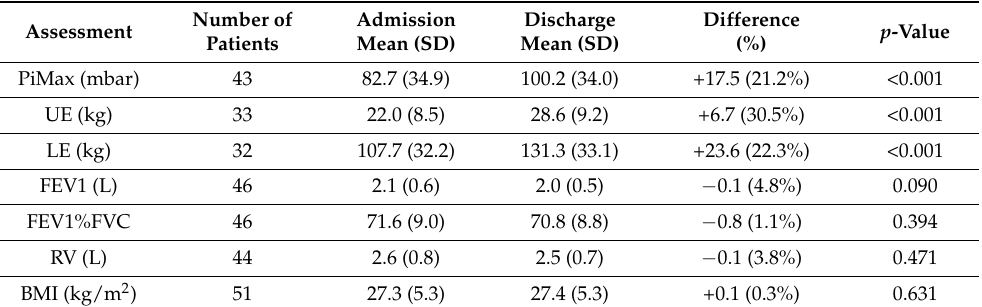
Table 3. Lung function, strength, and BMI assessment at admission and discharge of outpatient pulmonary